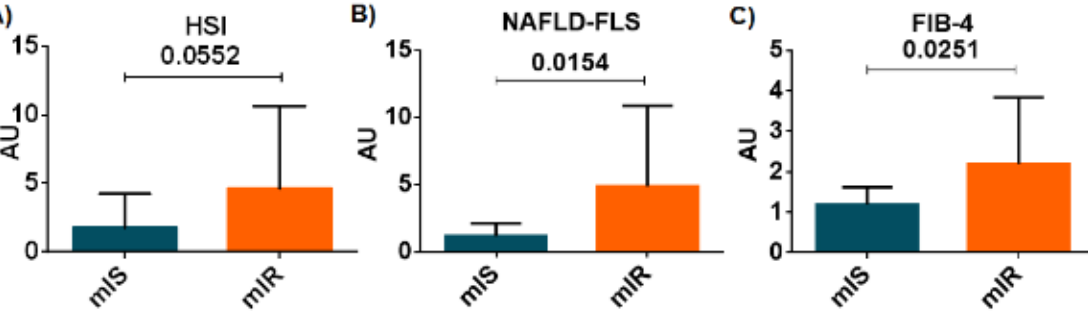
Figure 1. Differences between HIS ( A ), NAFLD-LFS ( B ) and FIB-4 ( C ) indexes between both pheno- types of T2D patients (ISm in blue and IRm in orange). Data are shown as mean ± SD.